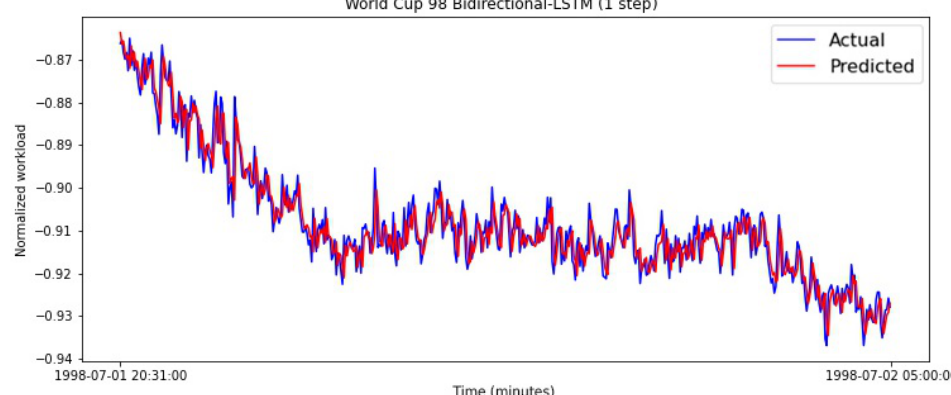
Figure 15. Bi-LSTM with one-step prediction on the testing set (from 1 July 1998 20:31:00 to 2 July 1998